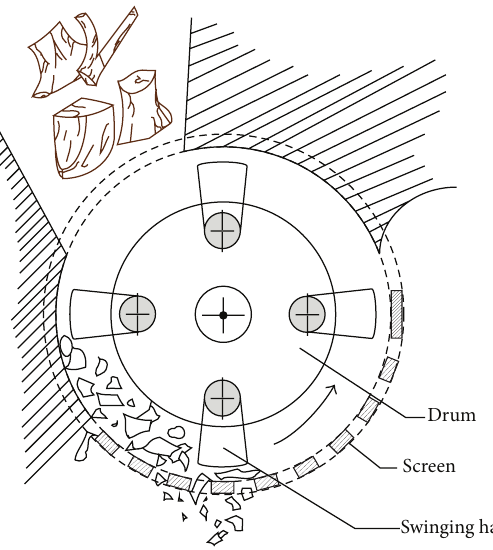
Figure 3: Illustration of a hammer